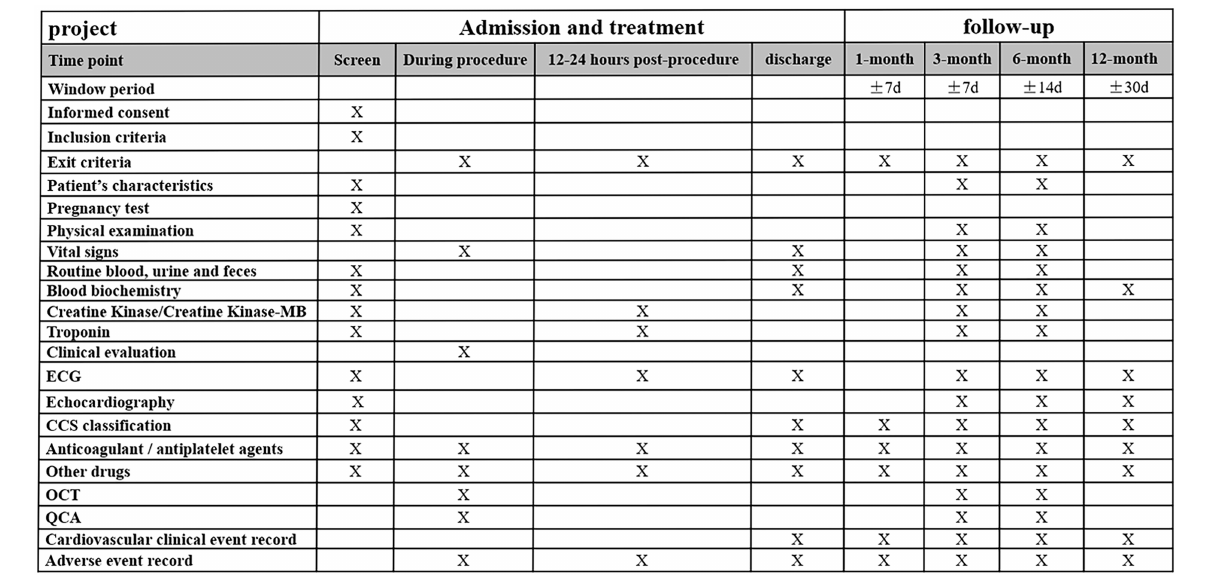
FIGURE 2 Time schedule of enrolment, interventions, and assessments of the study. ECG, electrocardiogram; CCS, Canadian cardiovascular society; OCT, optical coherence tomography; and QCA: quantitative coronary